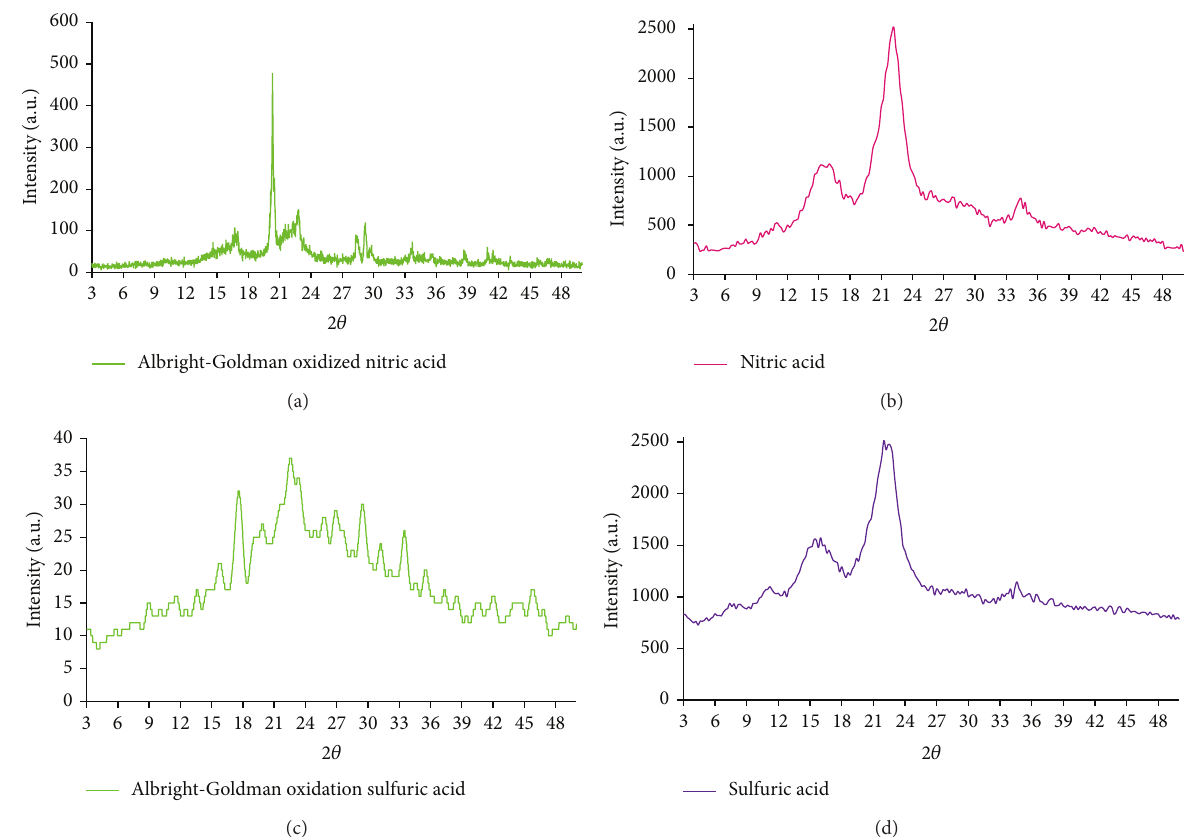
Figure 2: X-ray diffraction patterns of nitric acid extracted cellulose (a-b) and sulfuric acid extracted cellulose (c-d) and their Albright- Goldman modified